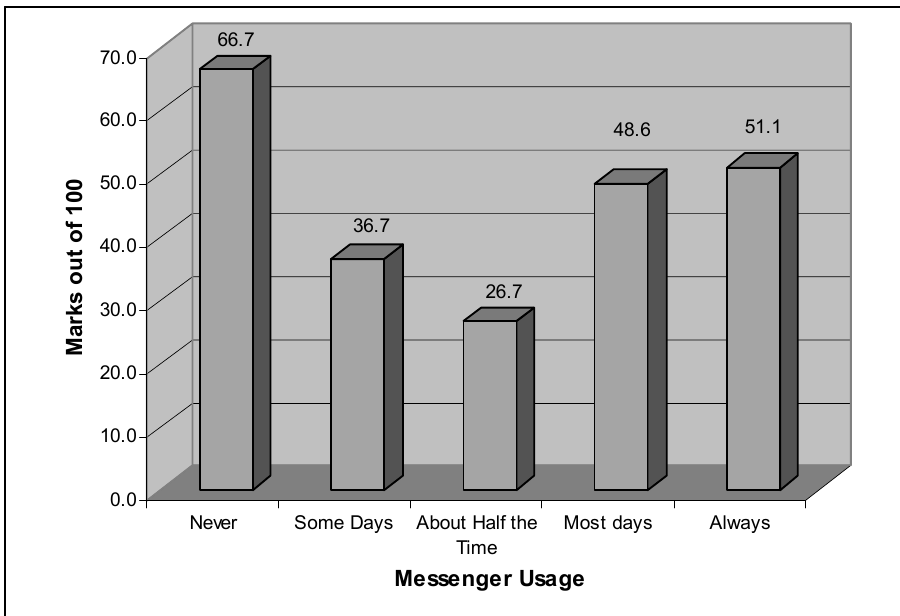
Figure 3. The marks for a piece of reflective writing compared with student use of